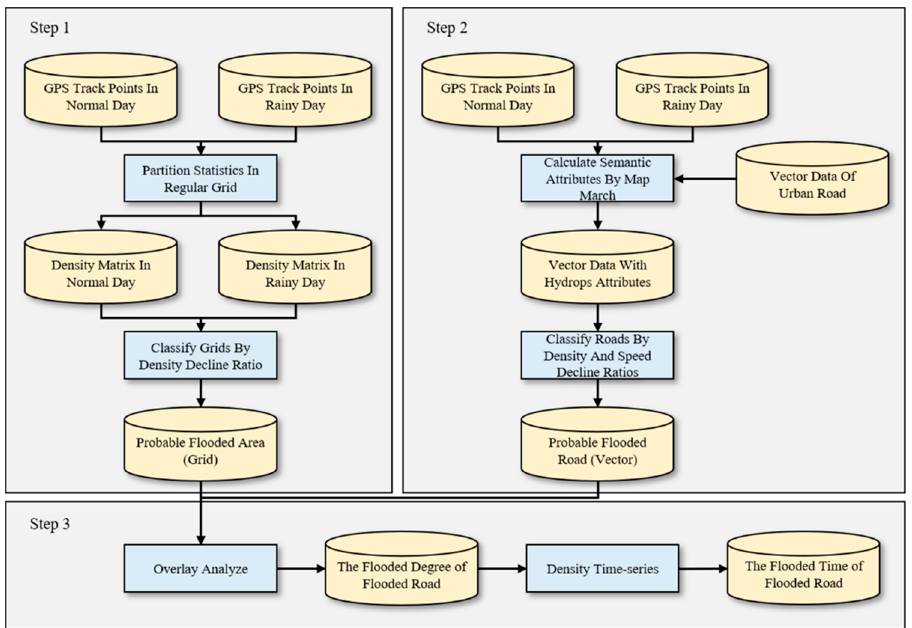
Figure 3. Workflow of flooded road extraction.